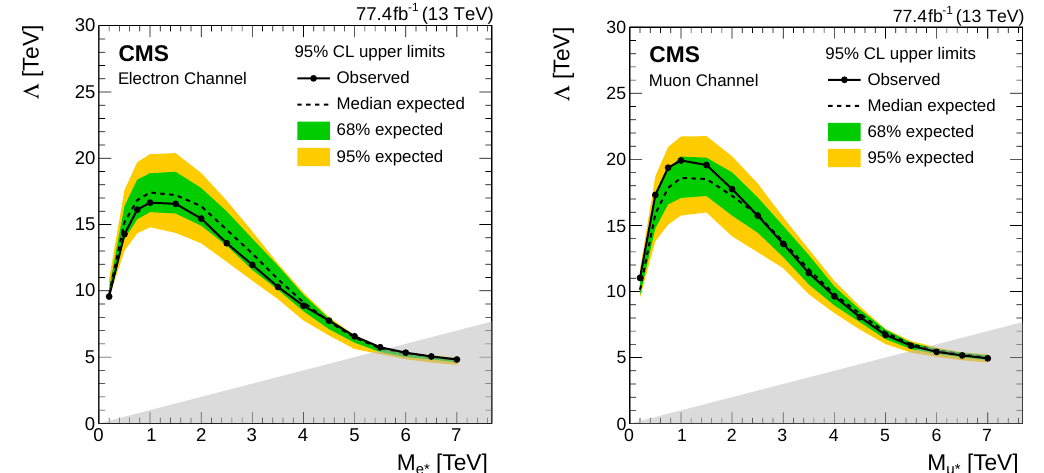
Figure 10 . Limits on the compositeness scale (cid:3) for the electron (left) and muon (right) channels, as a function of the mass of the excited lepton, for the case where the GI couplings set to 0.1. The model is not valid in the hatched area.